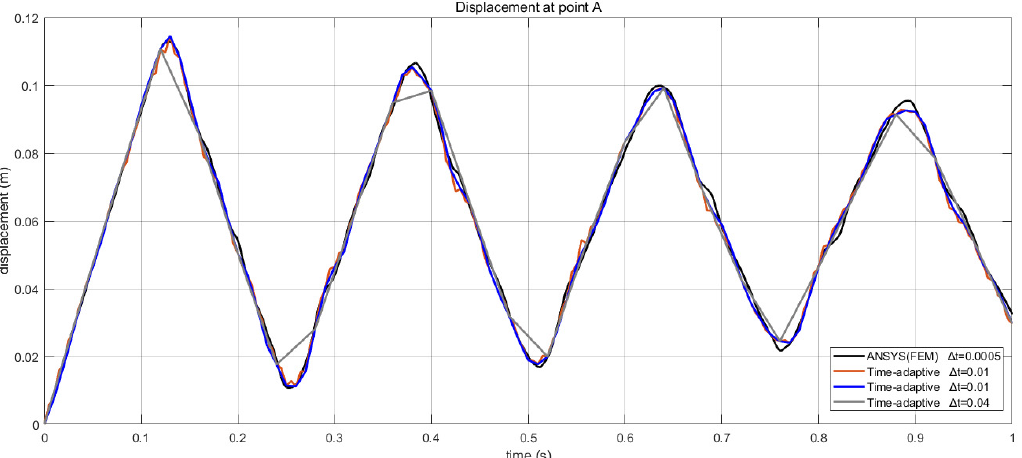
Figure 8. Displacements u x at point A using a time-adaptive method with different time steps (105 nodes with nodal distance d = 1.0 m ).